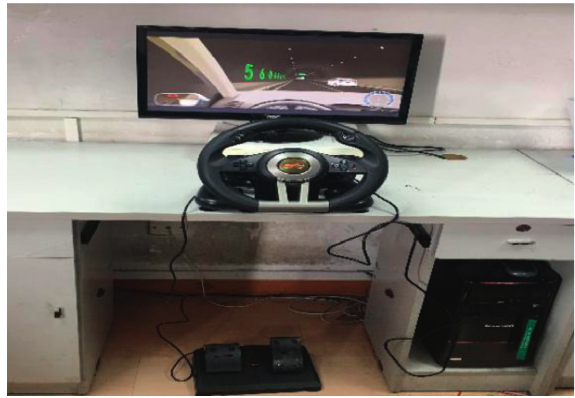
Figure 1: Driving simulator. Table 1: Maximum traffic volumes corresponding to different service levels of the